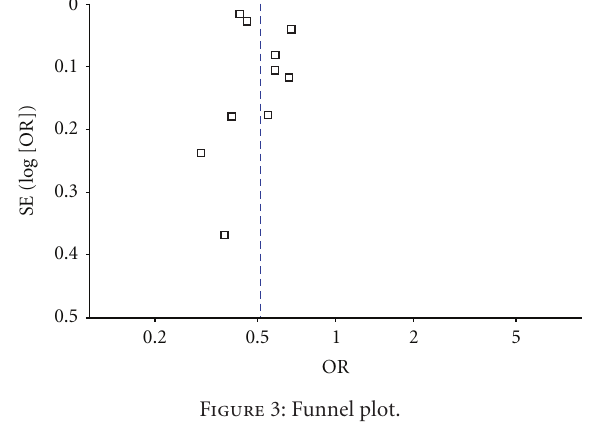
Figure 3: Funnel